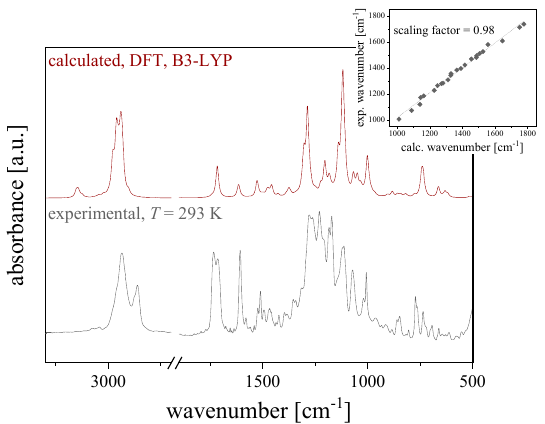
Figure 3. Calculated and experimental infrared spectra of 3F7HPhH7. The inset shows the Figure3. Calculatedandexperimentalinfraredspectraof3F7HPhH7. Theinsetshowsthedetermination determination of a scaling factor. of a scaling factor. Assignment of vibration modes observed on calculated (calc.) and